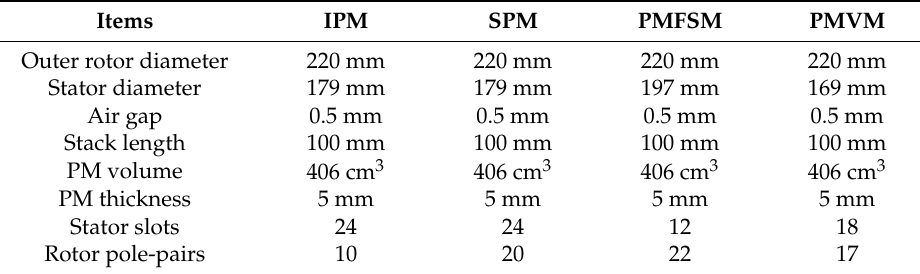
Table 2. Key Parameters of Proposed Six-phase Outer-rotor PM Machines.